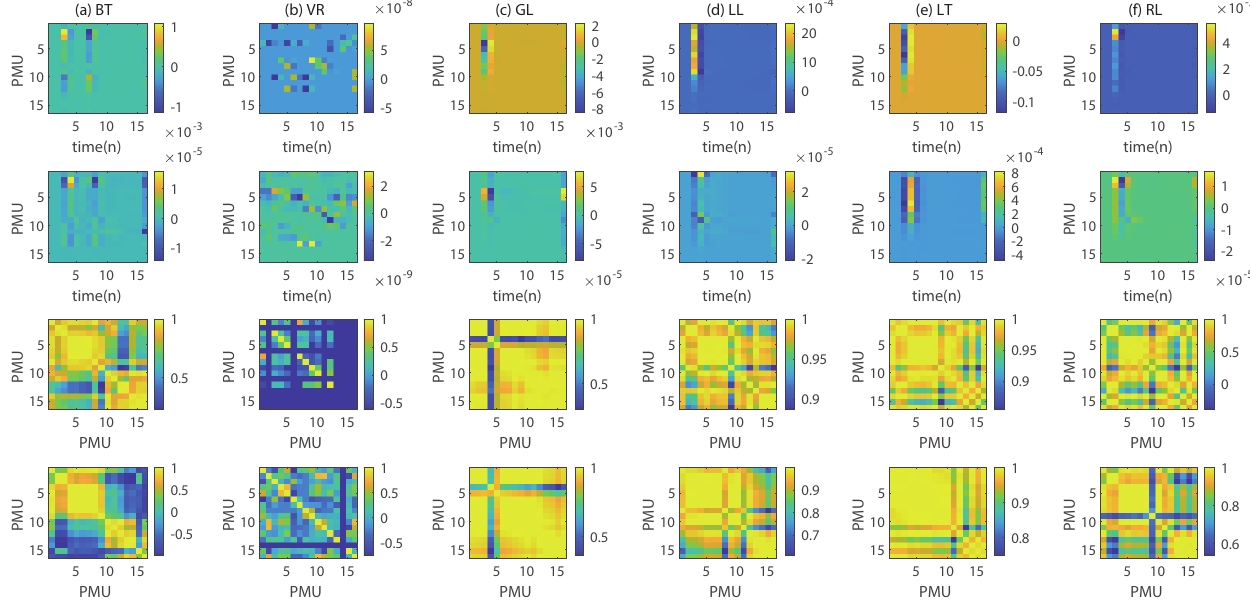
Figure 6. The typical 2-D features for six event type categories at ( a – f ): each row represents the IMG 1 V , IMG 1 F , IMG 2 V , IMG 2 F , respectively.